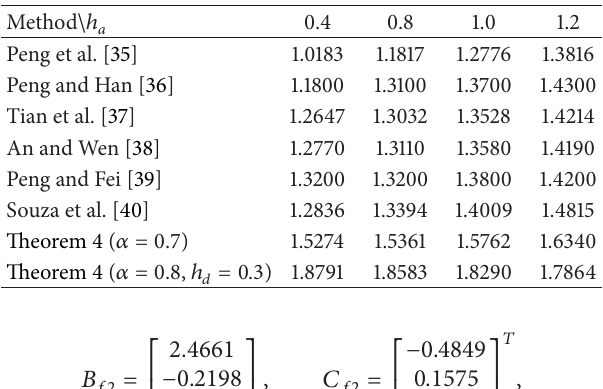
Table 3: Comparison with maximum values on ℎ 𝑏 for various ℎ 𝑎 ( ℎ 𝑑